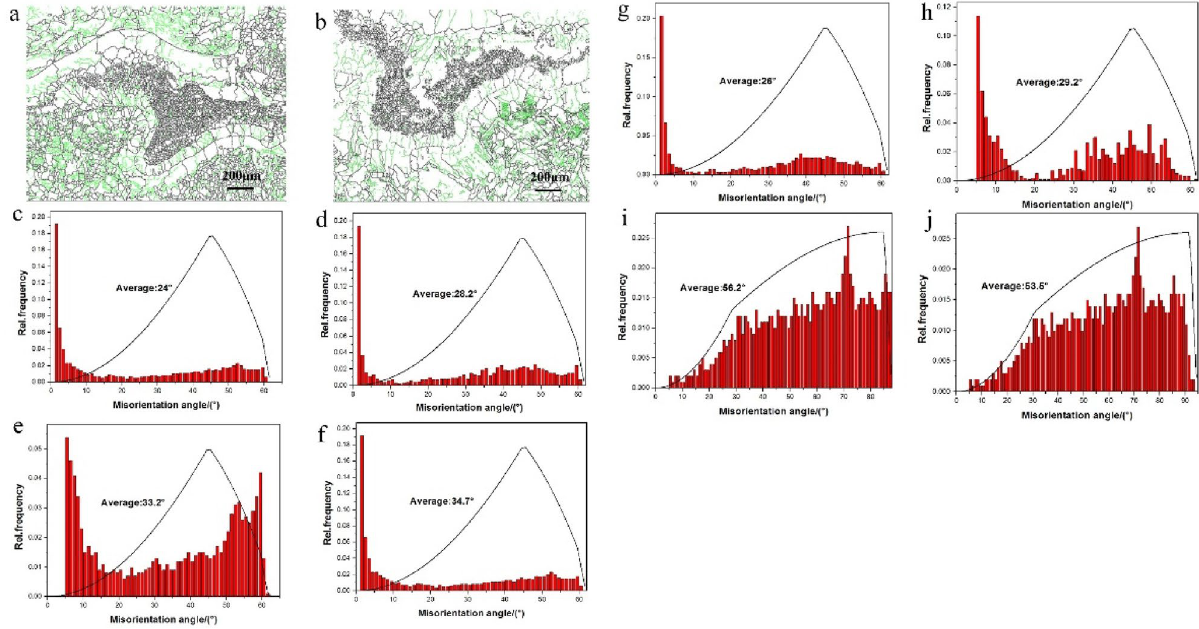
Figure 9. Grains boundary diagrams of different phases. (a,b) The grain boundary diagrams of process parameters 1 and 2, respectively. (c,d) Fe orientation diagrams of process parameters 1 and 2, respectively. (e,f) The Ti orientation diagrams of process parameters 1 and 2, respectively. (g,h) The FeTi orientation diagrams of process parameters 1 and 2, respectively, and ( i , j ) is the Fe2Ti orientation diagrams of process parameters 1 and 2,